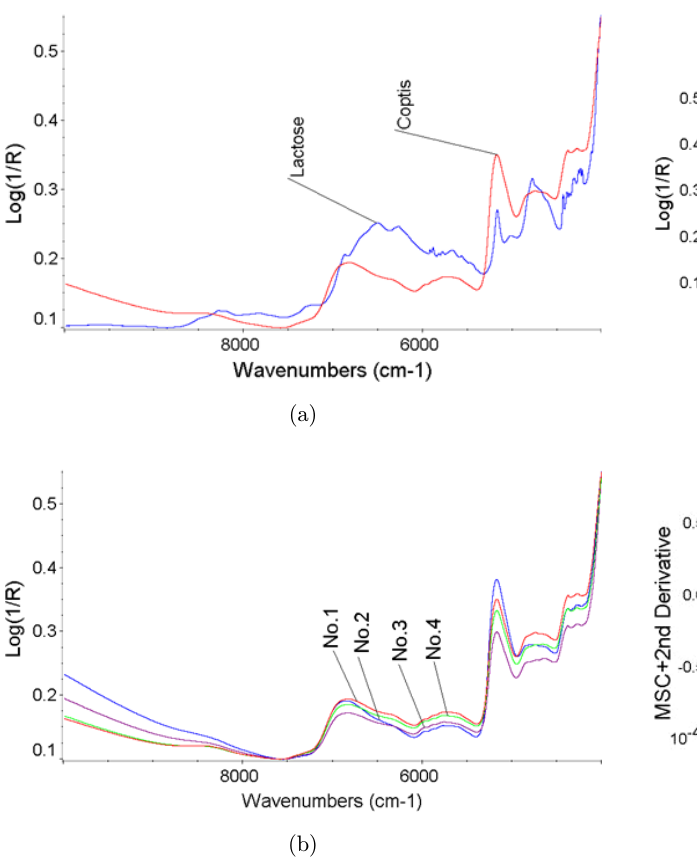
Fig. 2. NIR spectra collected of the 50% (w/w) blend batch 1 of 25 tumbling before (a) and after preprocessing